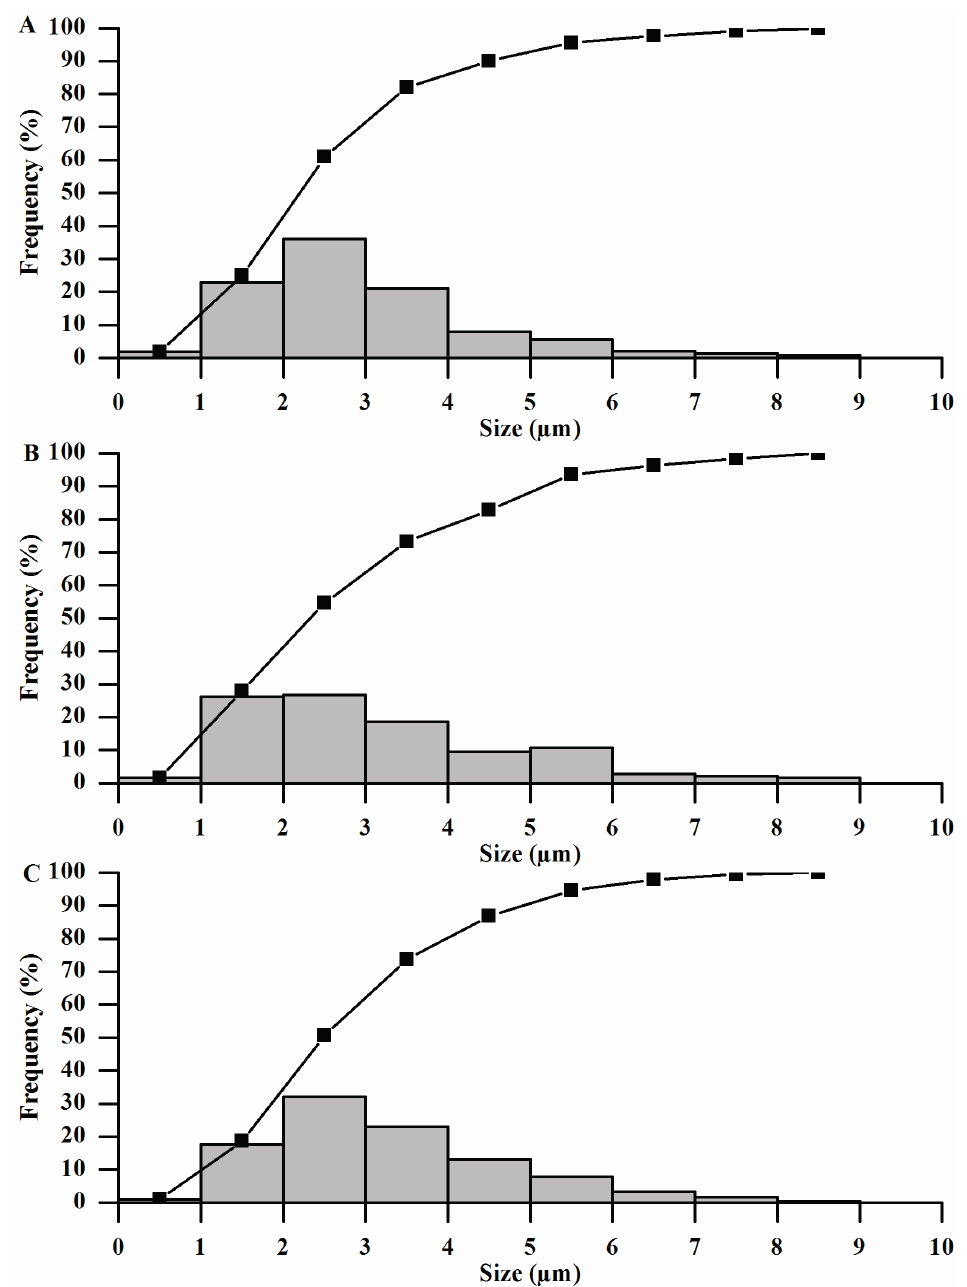
Figure 3. Size distribution of gelatin microparticles: ( A ) MP; ( B ) MP3; and ( C ) MP2. Size frequency distribution (bars) and cumulative size frequency distribution (lines). Frequency: percentage of particle in size interval (1